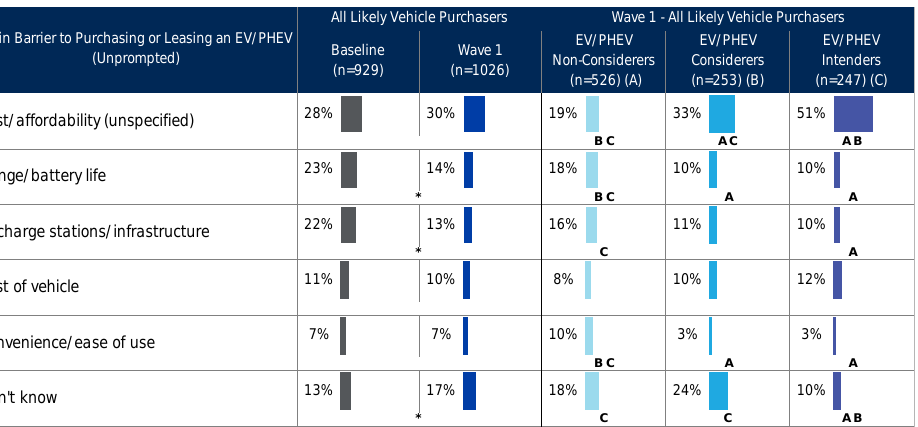
Figure 3. Unprompted reasons mentioned for purchasing or leasing a BEV or PHEV, by survey wave and segment (multiple responses allowed). Note: Letters A–C indicate statistically significant differences between likely vehicle purchaser segments (z-test for proportions, p < 0.05). * Indicates a statistically significant difference between Baseline and Wave 1 survey all likely vehicle purchas- ers (z-test for proportions, p < 0.05).